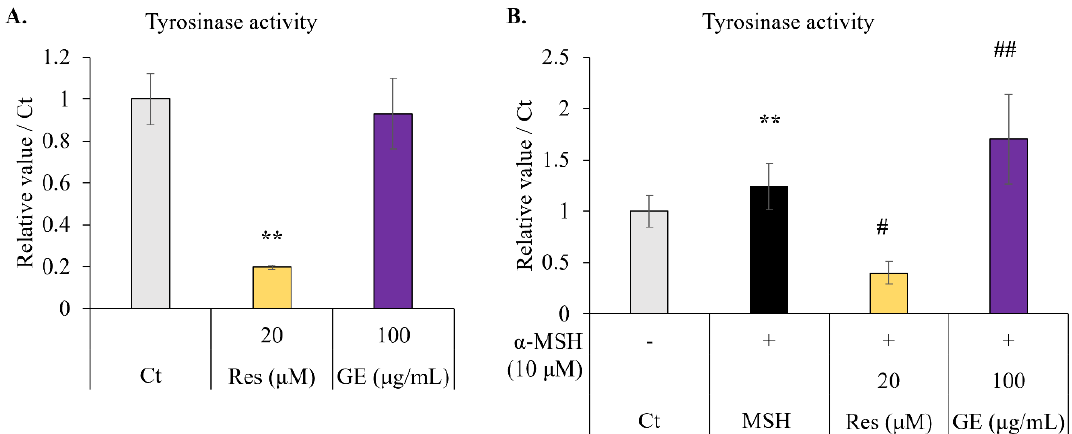
Figure 3. Effect of 72 h treatment with resveratrol (Res; 20 µ M) and grape extract (GE; 100 µ g/mL) on intracellular tyrosinase activity in B16F10 melanoma cells. The positive control for melanin synthesis was α -melanocyte-stimulating hormone ( α -MSH). After 72 h, L-DOPA was added to the cell lysate, and the tyrosinase activity was expressed in terms of the amount of melanin synthesized after 20 min, normalized to the total protein content of the cell. ( A ) Intracellular tyrosinase activity in melanocytes without α -MSH treatment. ( B ) Intracellular tyrosinase activity in melanocytes stimulated with α -MSH (10 µ M). The results are expressed as the mean ± standard deviation, n ≥ 3, ** p < 0.01 vs. Ct (non-treatment); # p < 0.05, ## p < 0.01 vs. α -MSH.